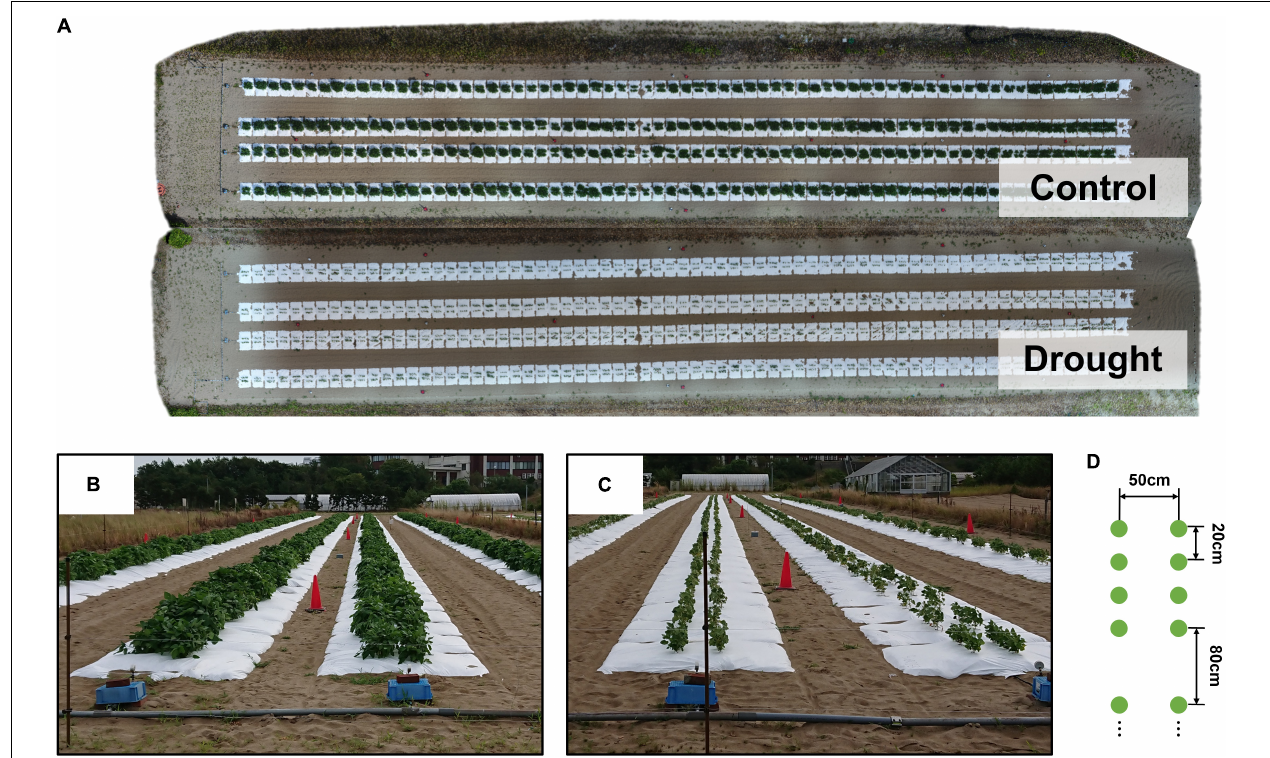
FIGURE 1 | The field experiment. (A) An ortho-mosaic image of the field, obtained on August 25, 2018. The ortho-mosaic images were created for each treatment. (B,C) Ground level images of treatments C and D. (D) Planting pattern of plots made of 2 rows of 4 plants (green dots) and separated by 80